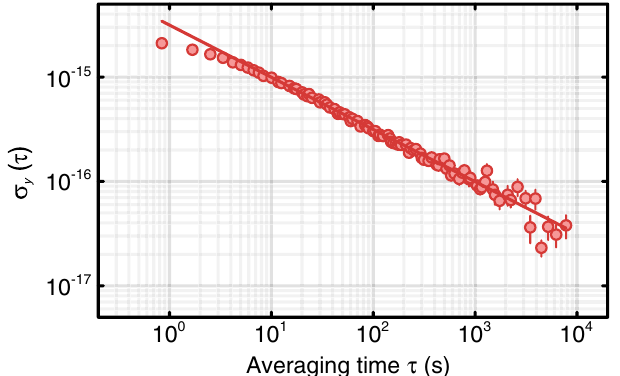
FIG. 8. Spatially resolved clock comparison. The fractional Allan deviation from an asynchronous clock comparison between the left and right halves of our array. Fitting a 1 = an initial lock onset time, we find 3 . 1 × 10 − 15 = than the result measured for a self-comparison of the full array (Fig. 4). Importantly, we see no upturn for times approaching 10 4 s and below the 10 − 16 level, indicating that slowly varying drifts of gradients across the array do not contribute to instability up to our